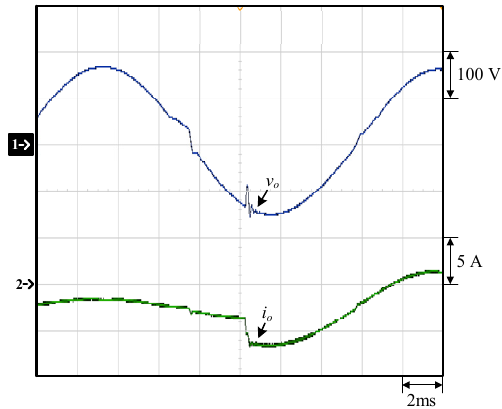
Figure 19. Load transient response due to step load current change from 25% to 100% load: (1) v o ; (2) i o .